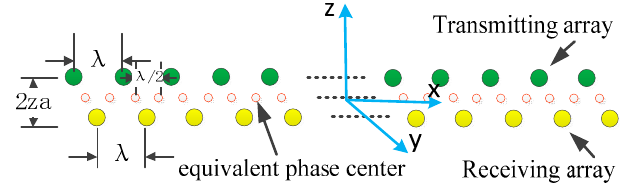
Figure 1. Array configuration of the transmitting and receiving elements.